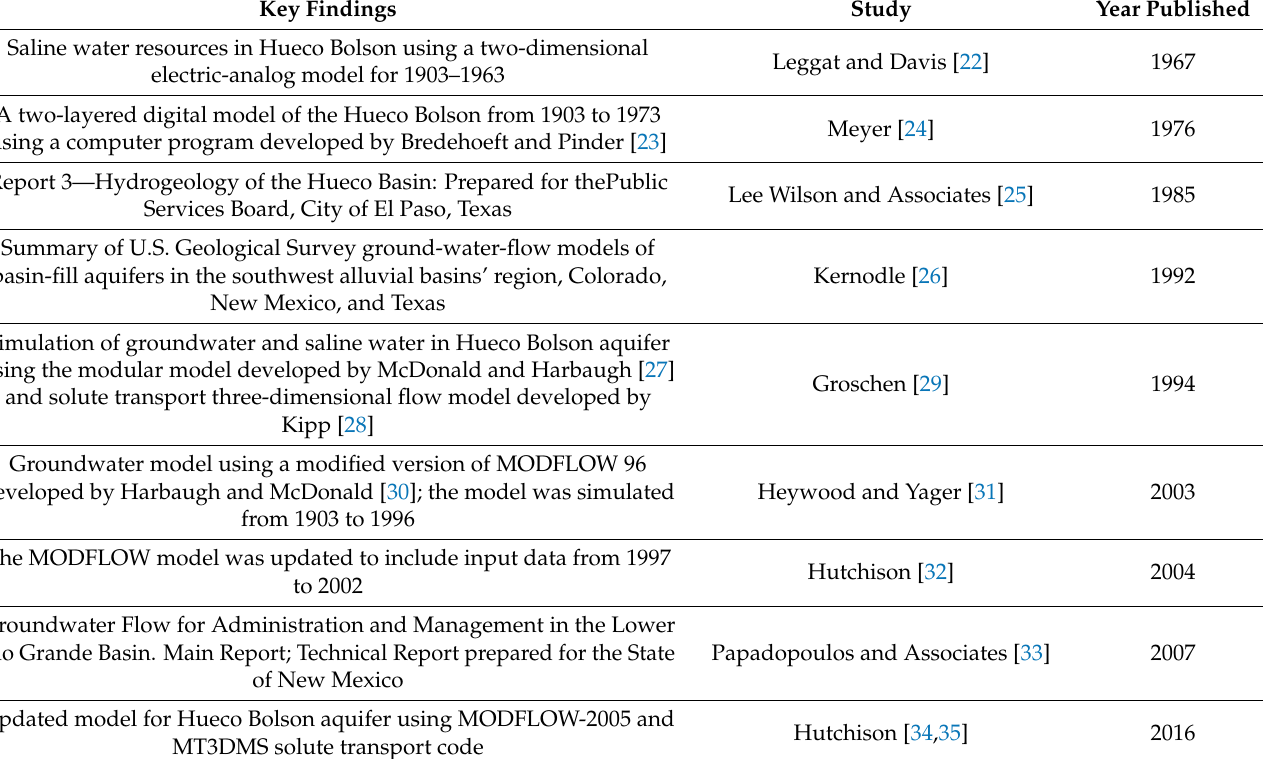
Table 1. List of major groundwater models of the Hueco